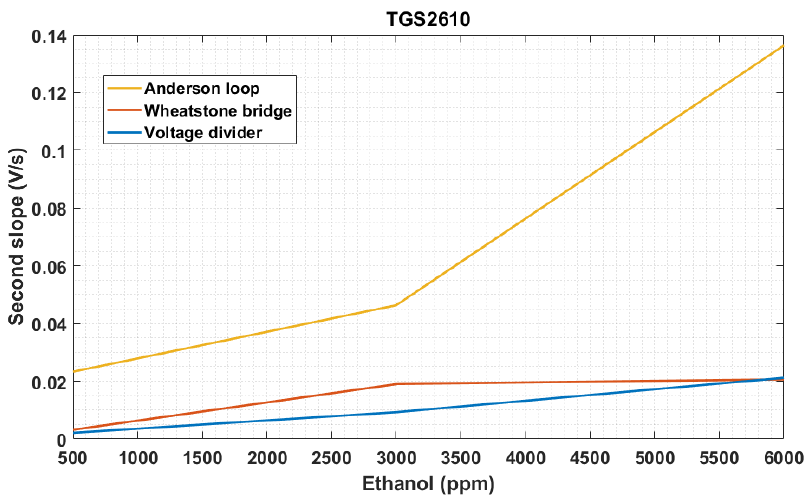
Figure 17. Value of second slope measured with the TGS 2610 when a measure of a sample starts.